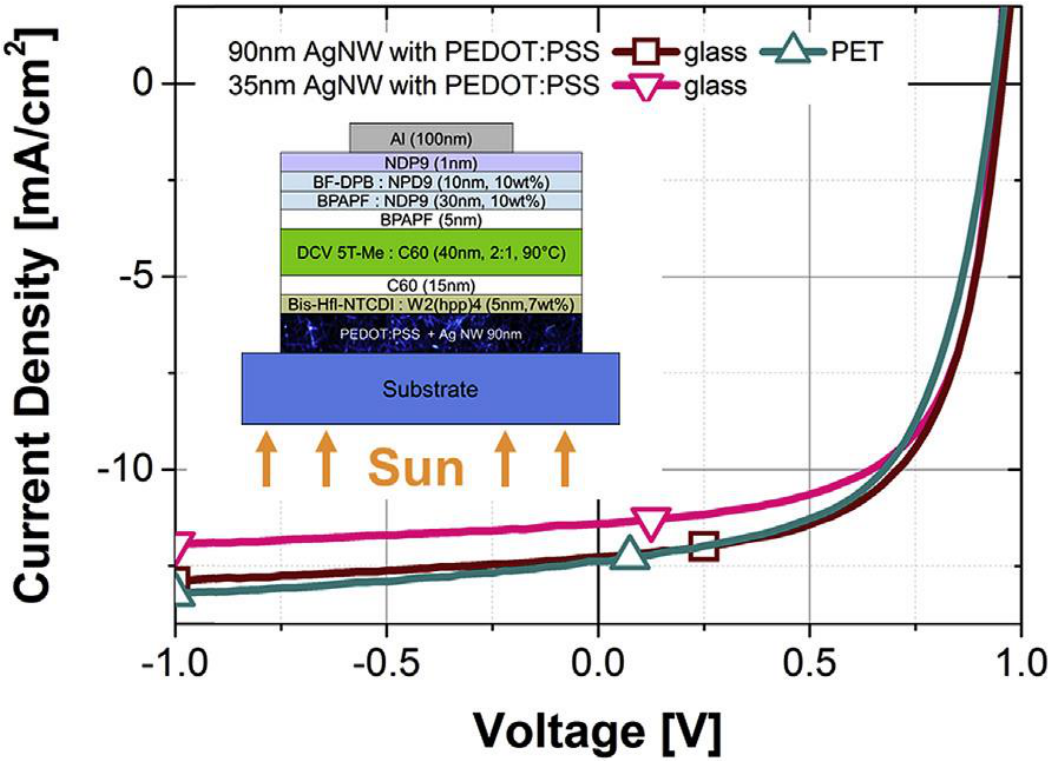
Figure 24. Current density-voltage (J-V) curve of organic photovoltaic (OPV) device